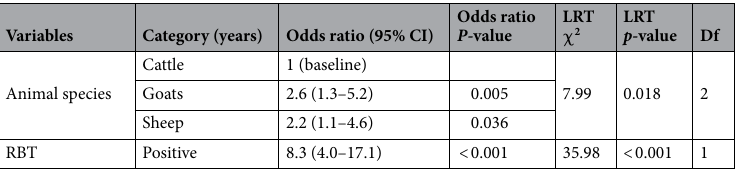
Table 4. Summary of multivariable mixed-effects logistic regression models run to predict Brucella spp. PCR status in livestock. Location icc = 0.4. CI confidence interval, P-value according to Pearson Chi-square test, Df degrees of freedom, RBT Rose Bengal Test, icc intra-cluster correlation coefficients.